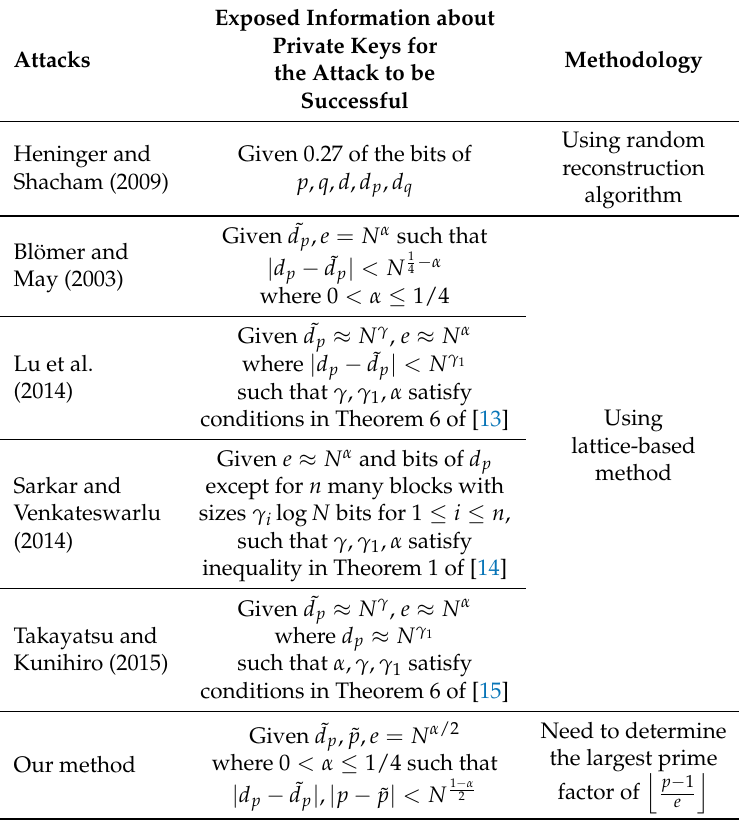
Table 3. Comparison of Our Method Against Existing Methods to Conduct Partial-Key Exposure Attack Against